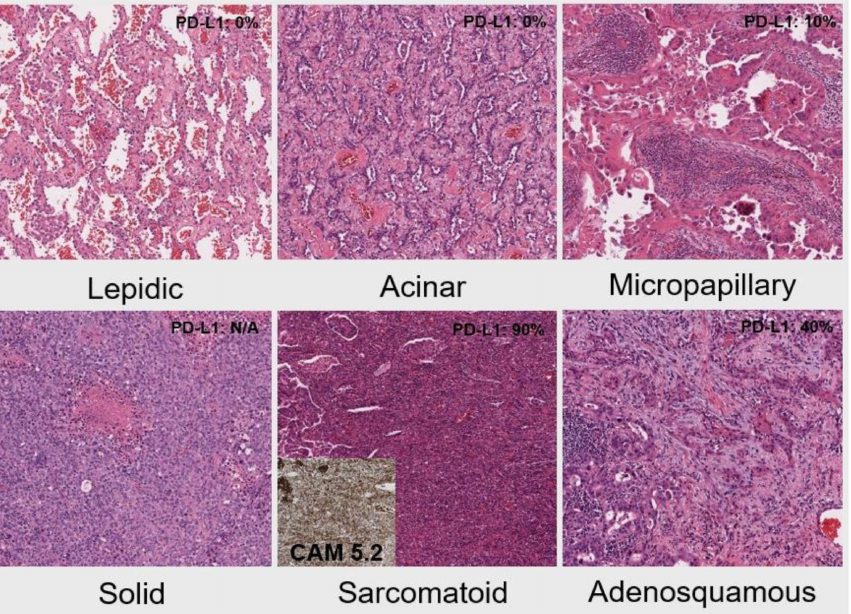
Figure 2. The histological types and growth pattern of NSCLC include lepidic pattern-predominant, acinar pattern-predominant, micropapillary-predominant, solid-predominant, sarcomatoid (inlet: